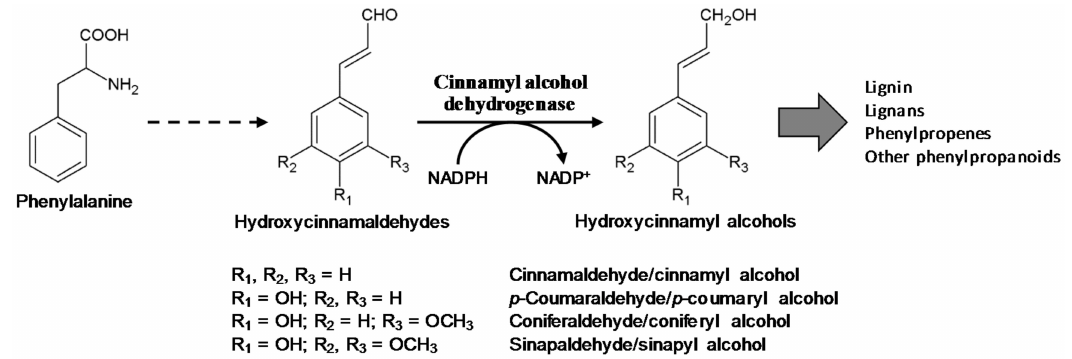
Figure 4. Cinnamyl alcohol dehydrogenase catalyzed reactions. The hydroxycinnamaldehyde substrates used in this study and the corresponding hydroxycinnamyl alcohols are